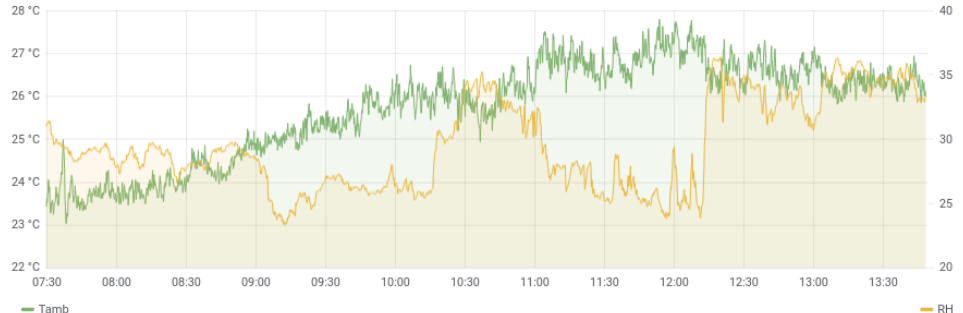
Figure 7. Ambient temperature ( T amb ) and relative humidity ( RH ) .